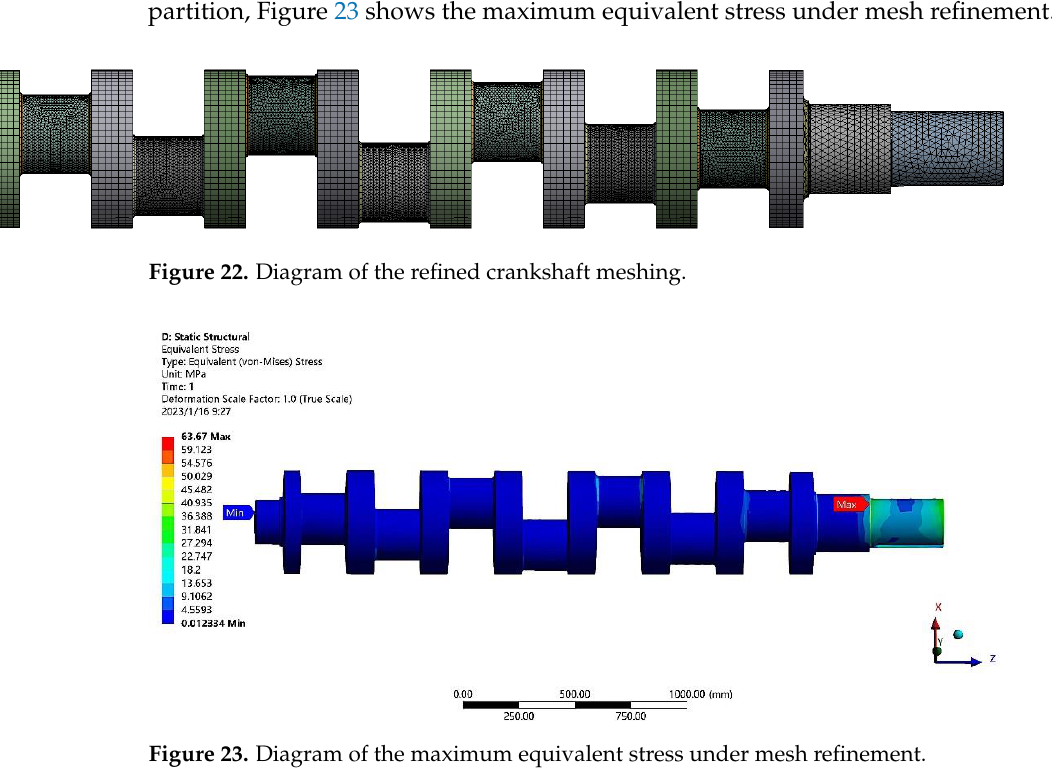
Figure 21. Diagram of maximum equivalent stress under automatic meshing .